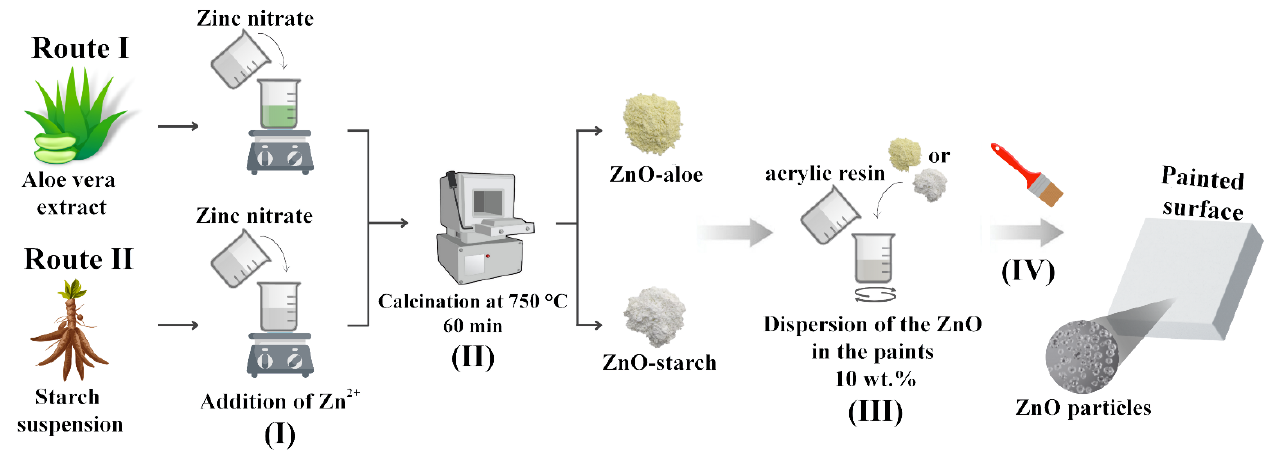
Figure 1. Schema of the different synthetic routes of obtaining nanostructured ZnO and its dispersion in waterborne acrylic coatings. Steps: (I) the addition of the zinc ions to the polysaccharides suspensions; (II) Calcination; (III) dispersion of the pigments in paint; and (IV) the exposure of the surface against the SARS-CoV-2 virus.